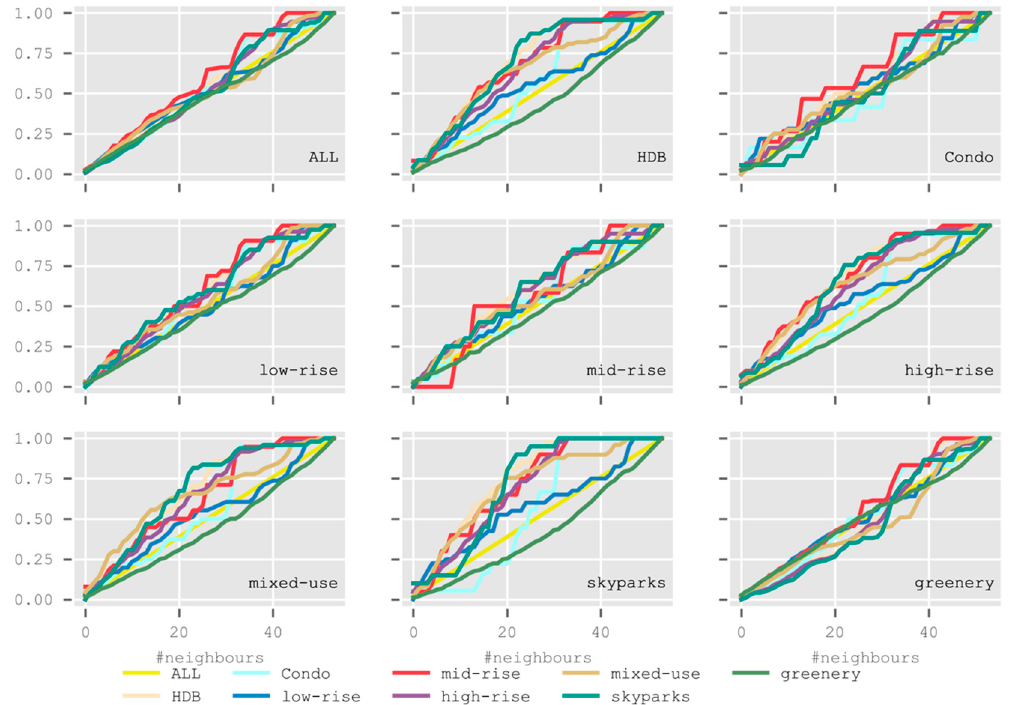
Figure 5. Nearest neighbors separated by object groups. The y -axis for each diagram shows the cumulated relative frequency (=density function) (CDF) of nearest neighbors, and the x -axis shows the nearest neighbor.